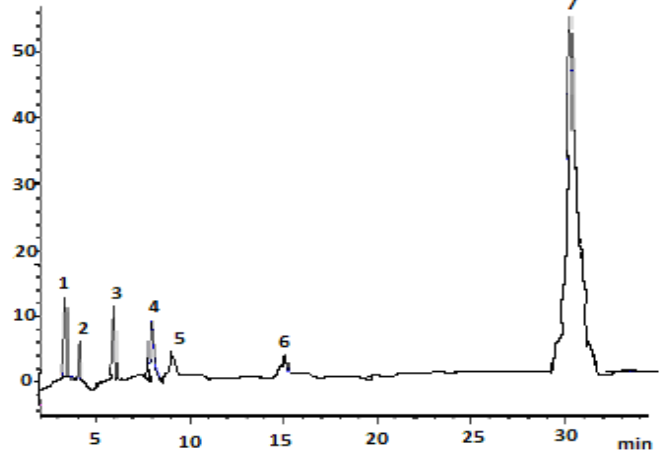
Figure 1. HPLC chromatogram of carotenoids in tomato waste acetone extract. The identified peaks include: ( 1 ) all- trans -lutein; ( 2 ) 9- cis -lutein; ( 3 ) 13- cis -lutein;